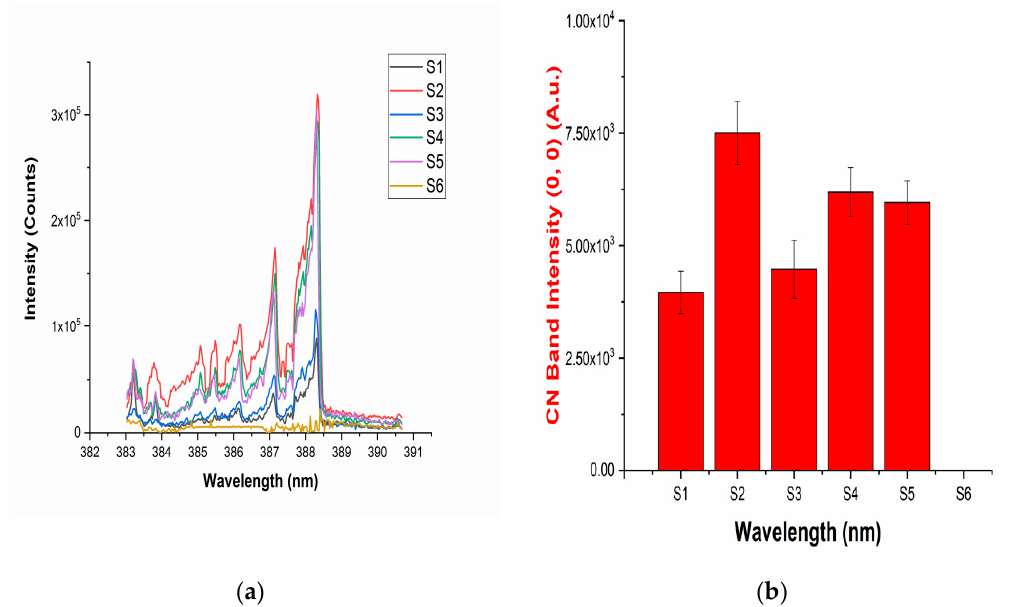
Figure 2. ( a ) The LIBS spectra of the drugs showing the presence of the vibrational band of a CN molecule; ( b ) intensities of the (0,0) band of the CN band present in the LIBS spectra of the drugs.